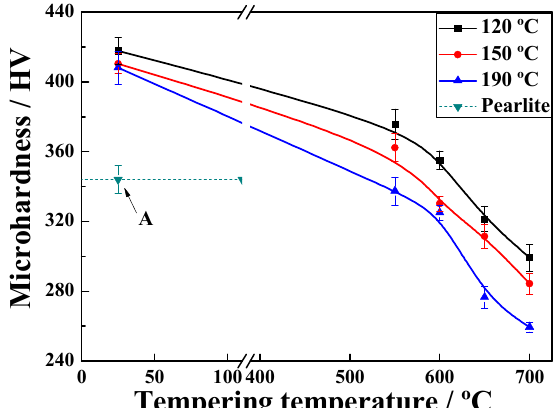
Figure 2. Microhardness curves for samples processed at different quenching temperatures and different tempering temperatures. Black, red, and blue lines indicate the samples quenched at 120 ◦ C, 150 ◦ C and 190 ◦ C, respectively. Point “A” indicates the microhardness of the original pearlitic steel.